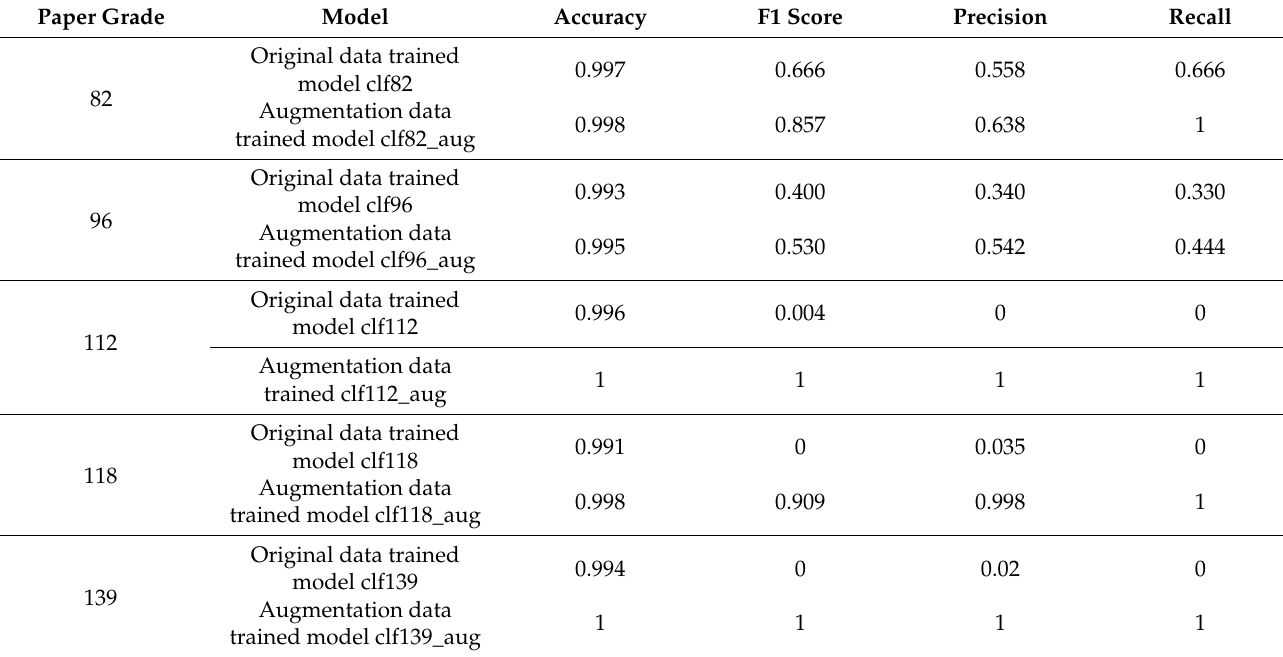
Table 7. The performance of logistic